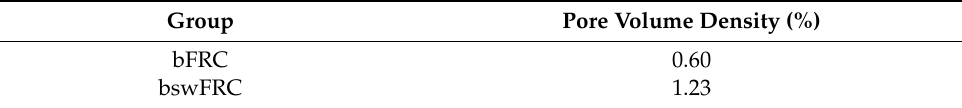
Figure 2. Representative scanning electron microscopy photos of bFRC and bswFRC fractures at different magnifications (×31, ×500 and ×1000). Black arrows indicate a shear fracture in bFRC sample. Table 2. Pore volume density (%) of bFRC and bswFRC as calculated from X-ray tomography imaging.